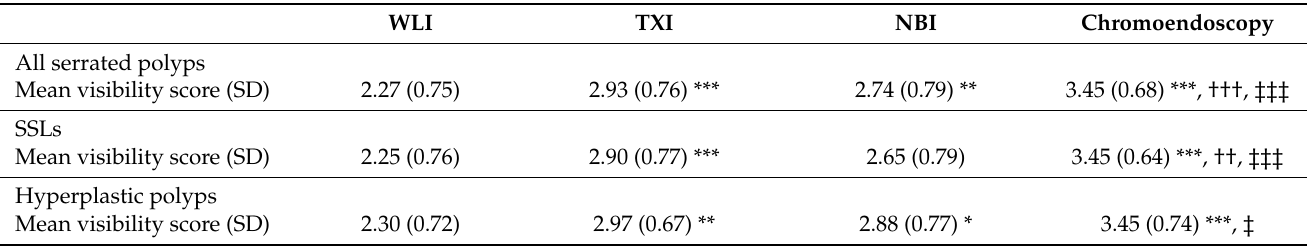
Table 2. Visibility scores without magnification for WLI, TXI, NBI, and chromoendoscopy.